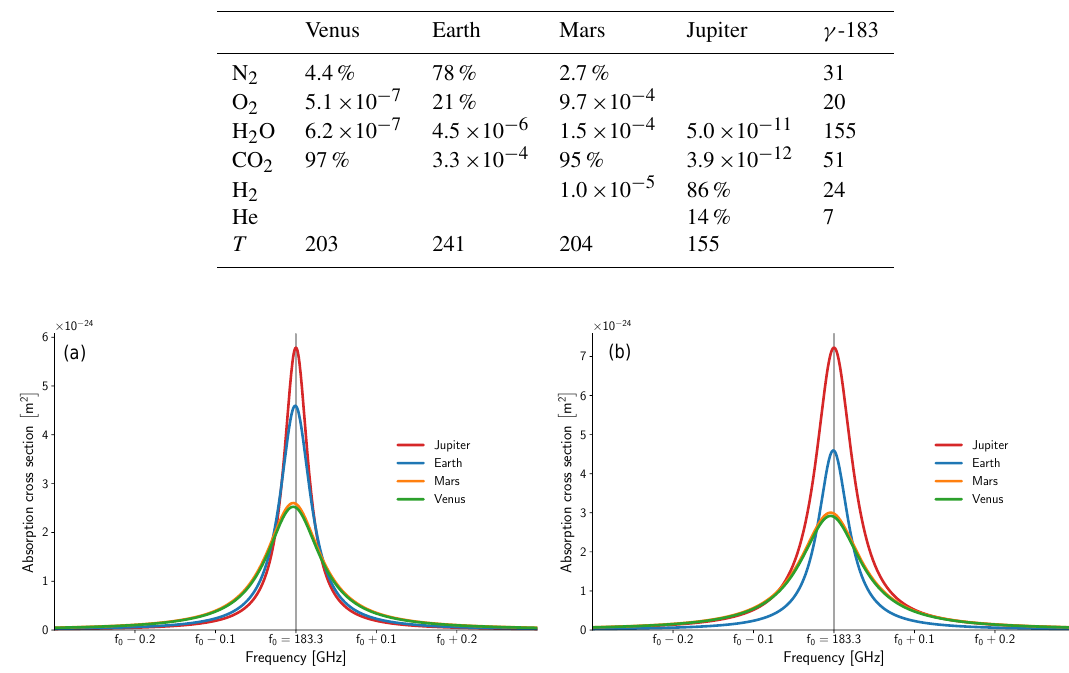
Table 2. The table shows the basic composition of different planets. The table lists VMR values at 700Pa for some basic model atmospheres that are distributed with ARTS as part of the “arts-xml-data” package. (See documentation in arts-xml-data for data origin; the scenarios used are as follows: Venus – Venus.vira.day; Earth – Fascod/tropical; Mars – Ls0.day.dust-medium.sol-avg; Jupiter – Jupiter.mean.) The last row, T , lists temperature values in kelvin from the same atmospheres. The last column, γ -183, lists pressure broadening parameters of the 183GHz H 2 O line in kHzPa − 1 . Note that the VMRs are not normalized, so they do not exactly add up to 1 for each planet. Also note that these are only the gases for which we have dedicated broadening parameters; all planets also have other trace gases that are spectroscopically active.